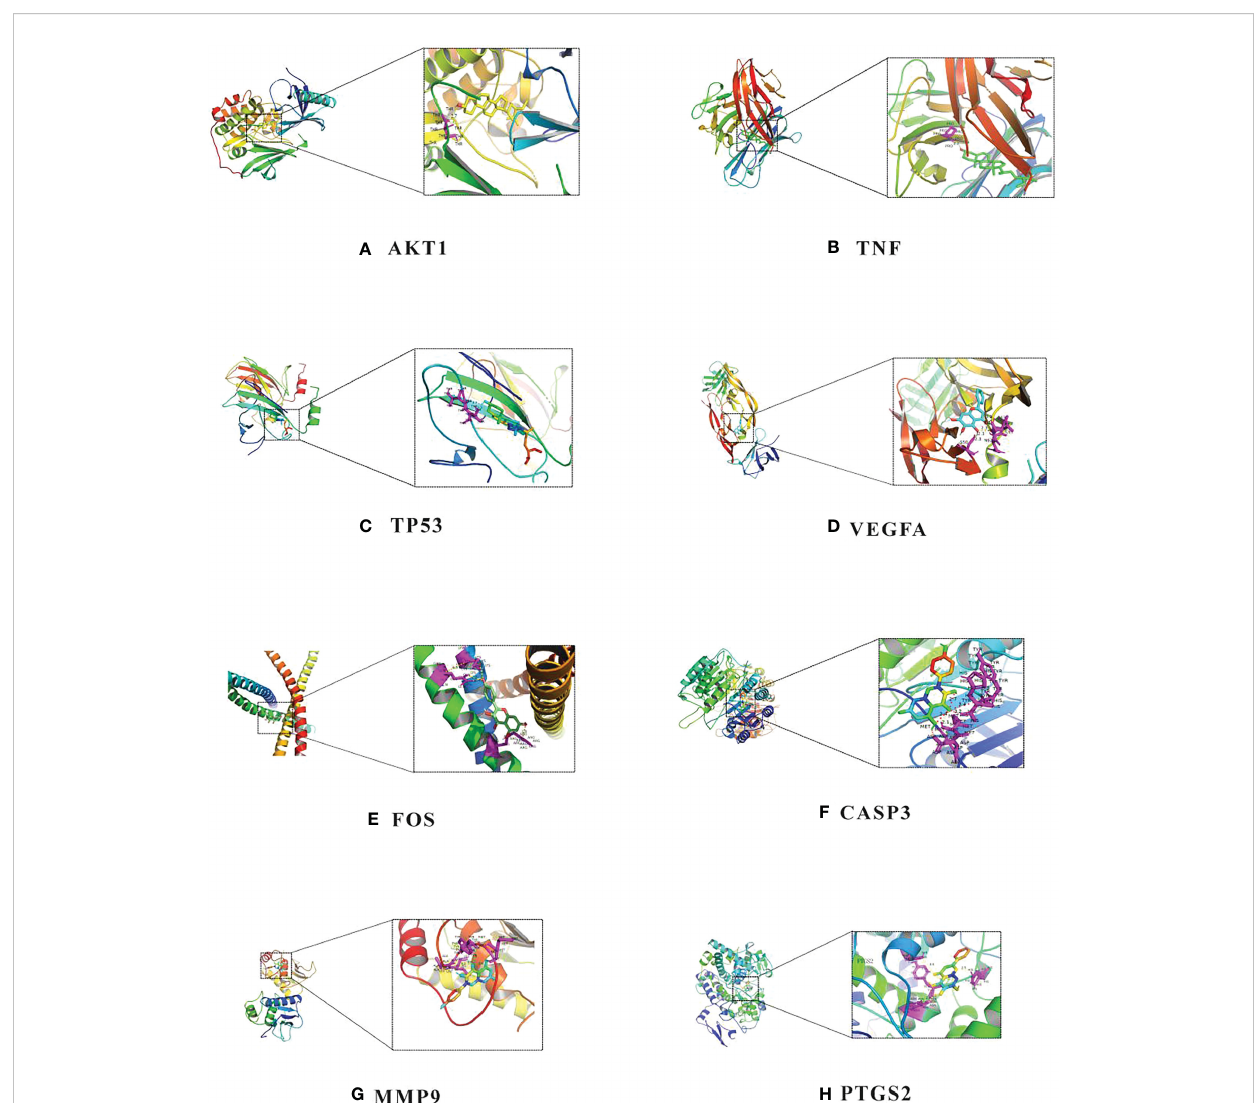
FIGURE 9 Molecular docking diagram of chemical composition to target: (A) AKT1 to beta-sitosterol; (B) TNF to beta-sitosterol; (C) TP53 to kaempferol; (D) VEGFA to baicalein; (E) FOS to kaempferol; (F) CASP3 to kaempferol; (G) MMP9 to kaempferol; (H) PTGS2 to